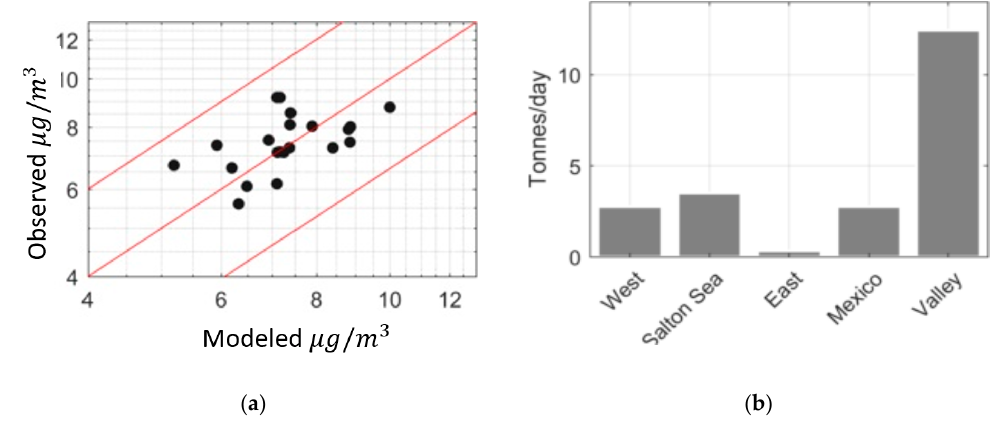
Figure 6. ( a ) Model performance for annually averaged data (red lines show factor of 1.5 deviations about observations). ( b ) Annual emission rates for different source categories inferred from the modeling.